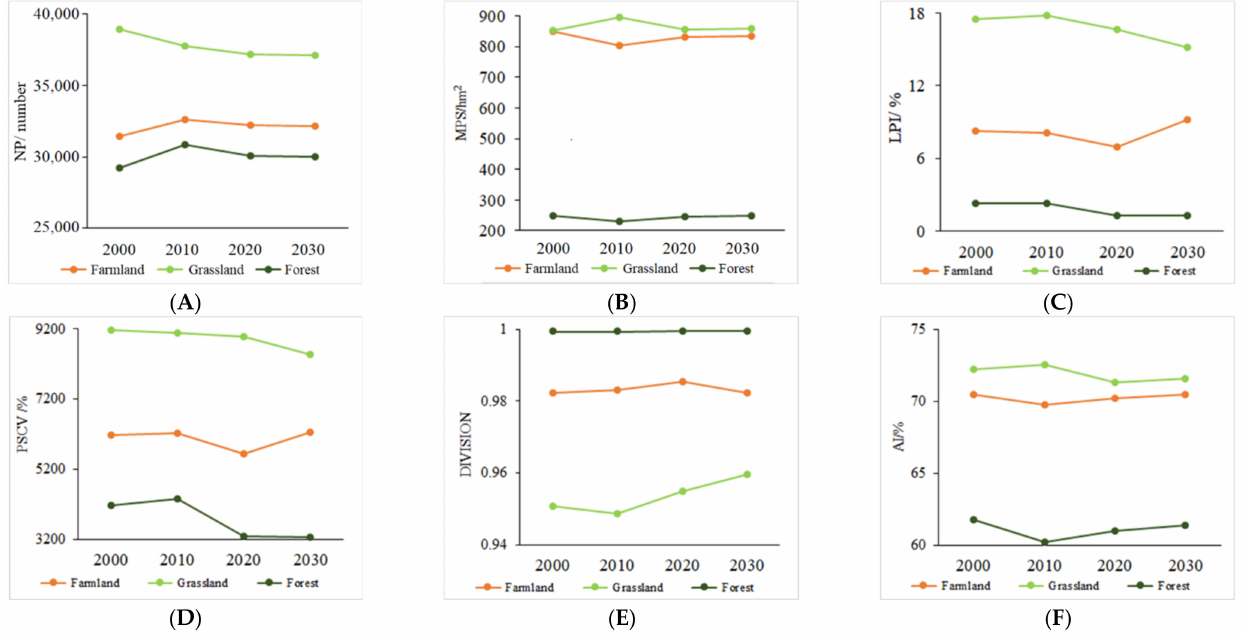
Figure 7. Changes in class metrics from 2000 to 2030. ( A ) NP; ( B ) MPS; ( C ) LPI; ( D ) PSCV; ( E ) DIVISION; ( F )